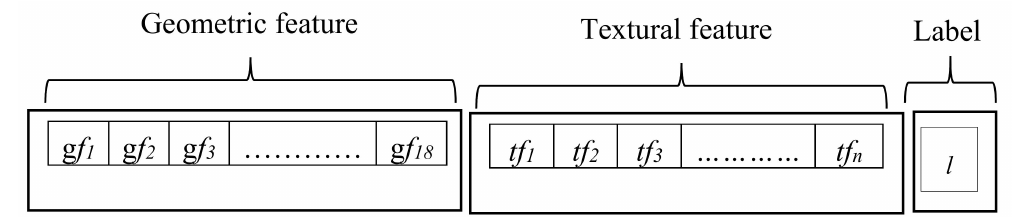
Figure 13. Combined features using geometric and texture